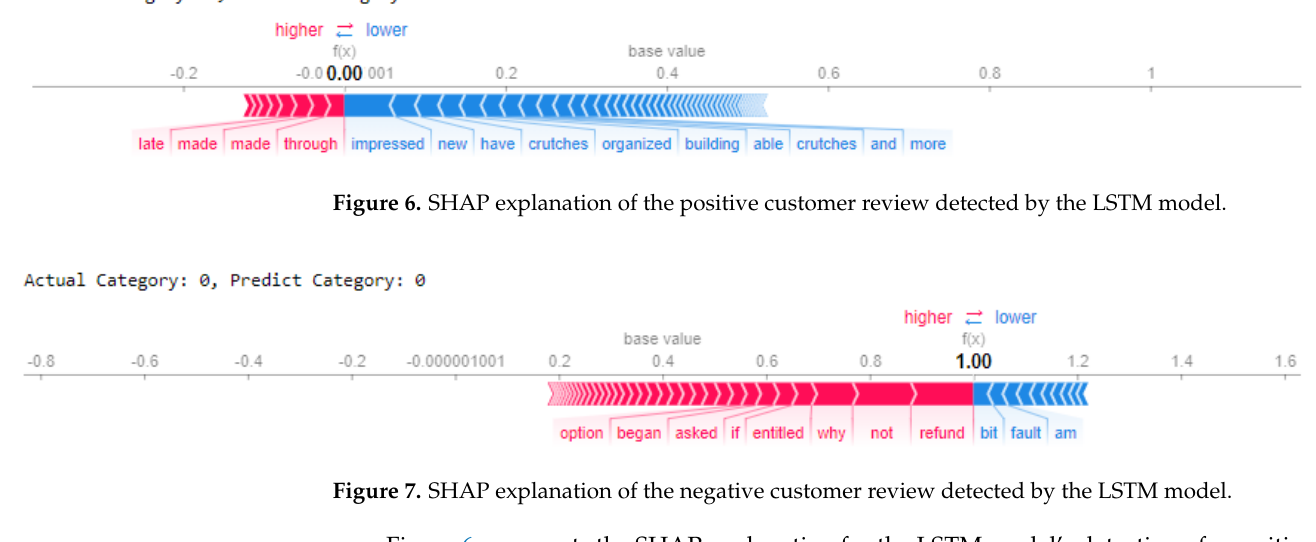
Figure 7. SHAP explanation of the negative customer review detected by the LSTM